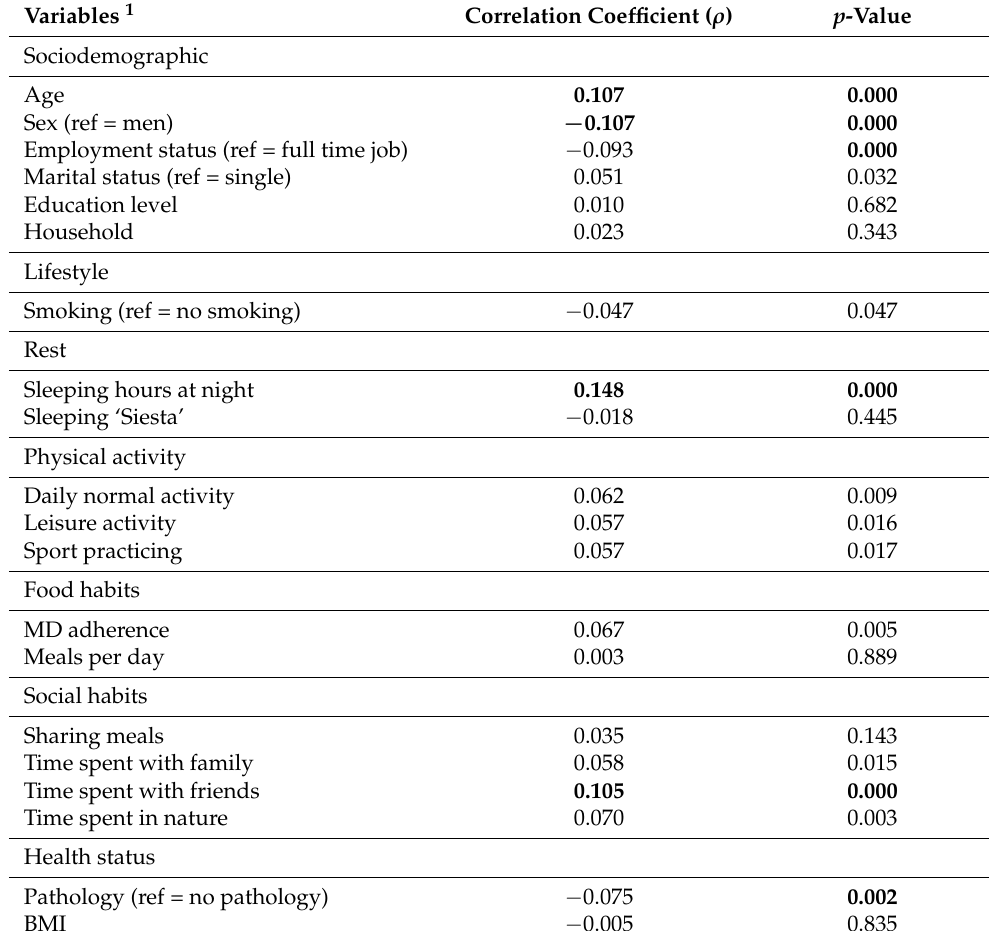
Table 6. Non-parametric partial correlations between sociodemographic, health status related factors, and MED lifestyle factors and the 9-item SWB